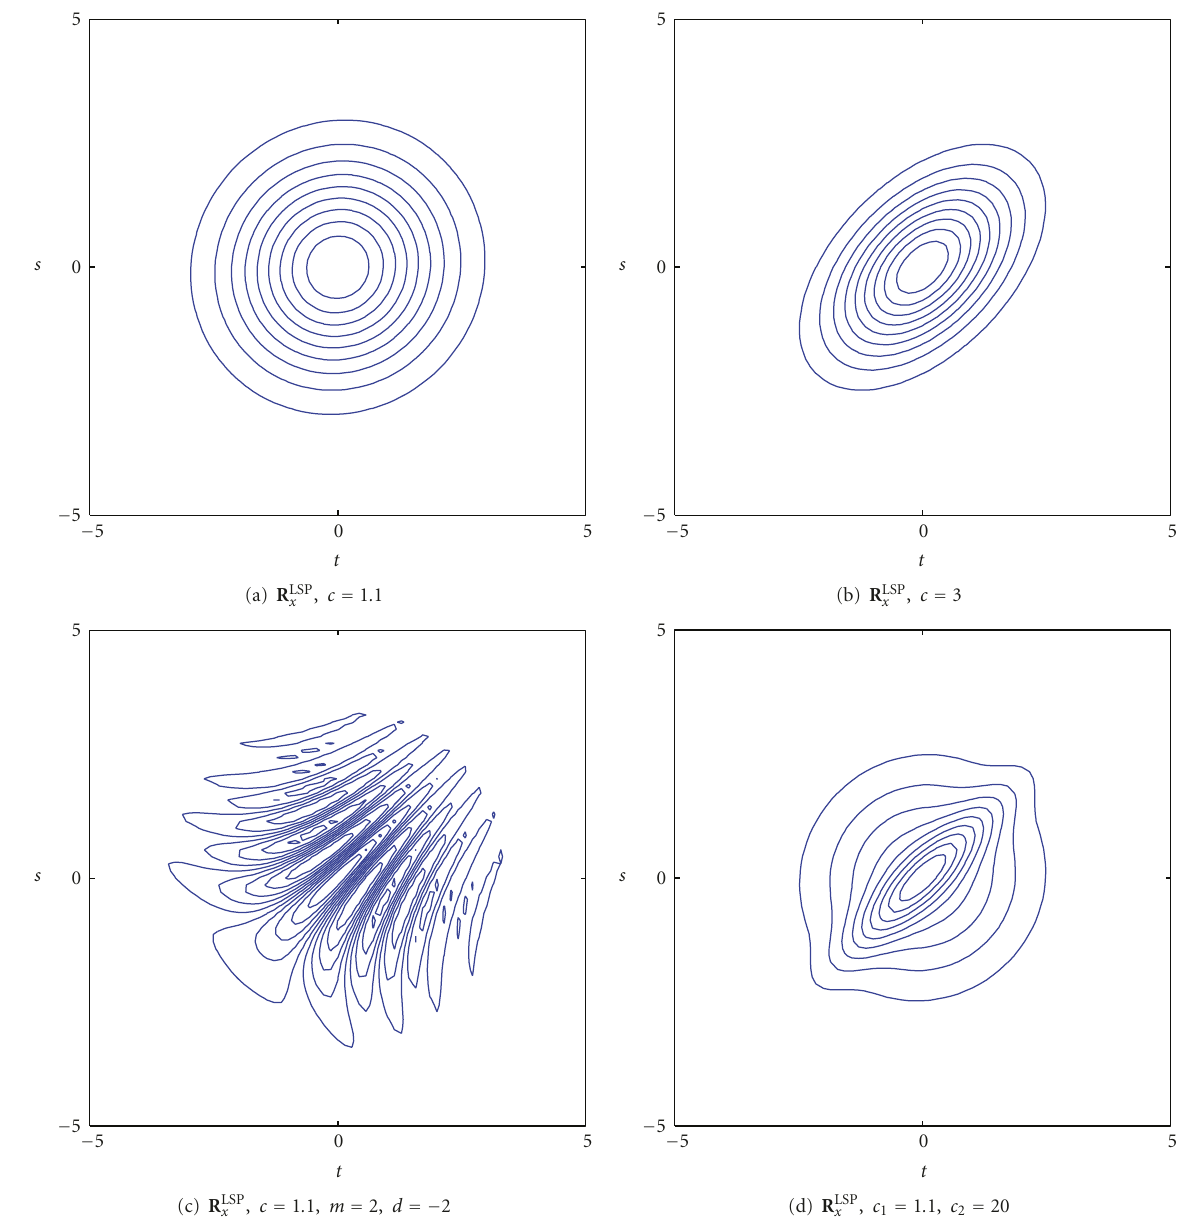
Figure 1: Examples of covariance matrices R x of LSP for di ff erent parameter values with N = 256 and F s = 7: (a) LSP: c = 1 . 1, (b) LSP: c = 3, (c) LSCP: c = 1 . 1, m = 2, d = − 2 (real-valued part only), and (d) MLSP: c 1 = 1 . 1, c 2 =